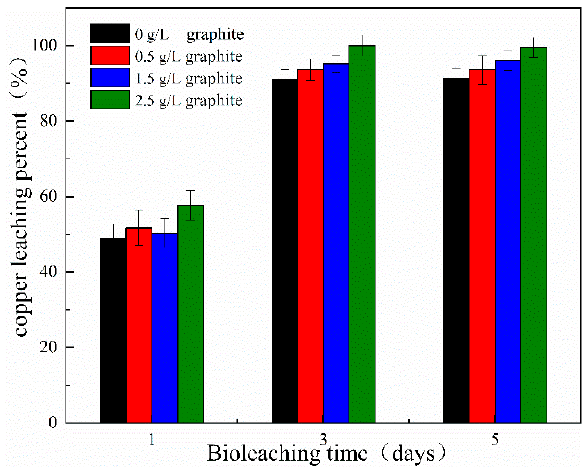
Figure 8. Copper-leaching percentage (mean ± SD) during WPCB bioleaching at different graphite concentrations (other conditions: 1.6 pH, 2% ( w / v ) pulp density, 45 °C, 170 rpm).